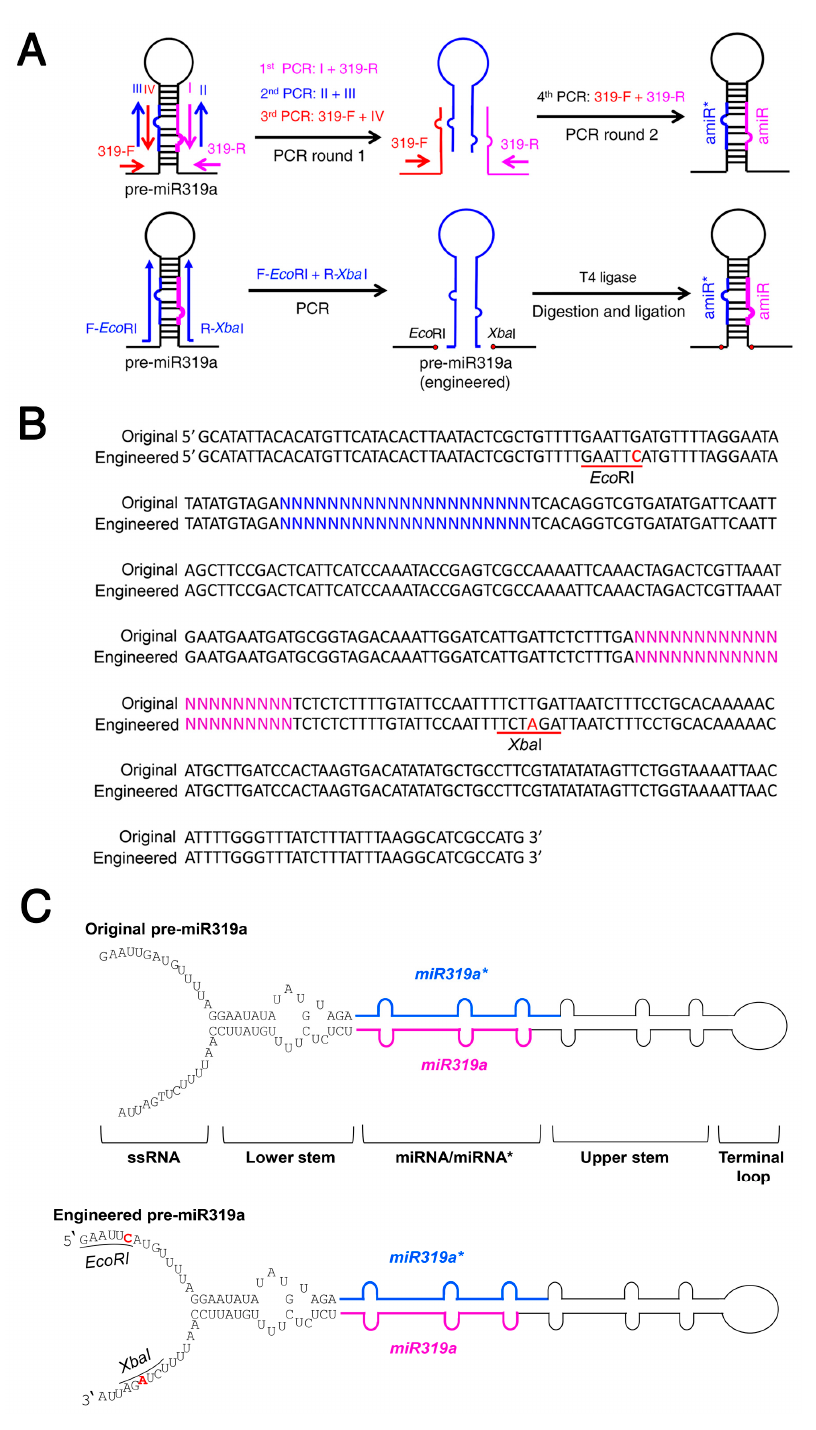
Figure 1. Engineered Arabidopsis miR319a precursor allows a one-step construction of a new